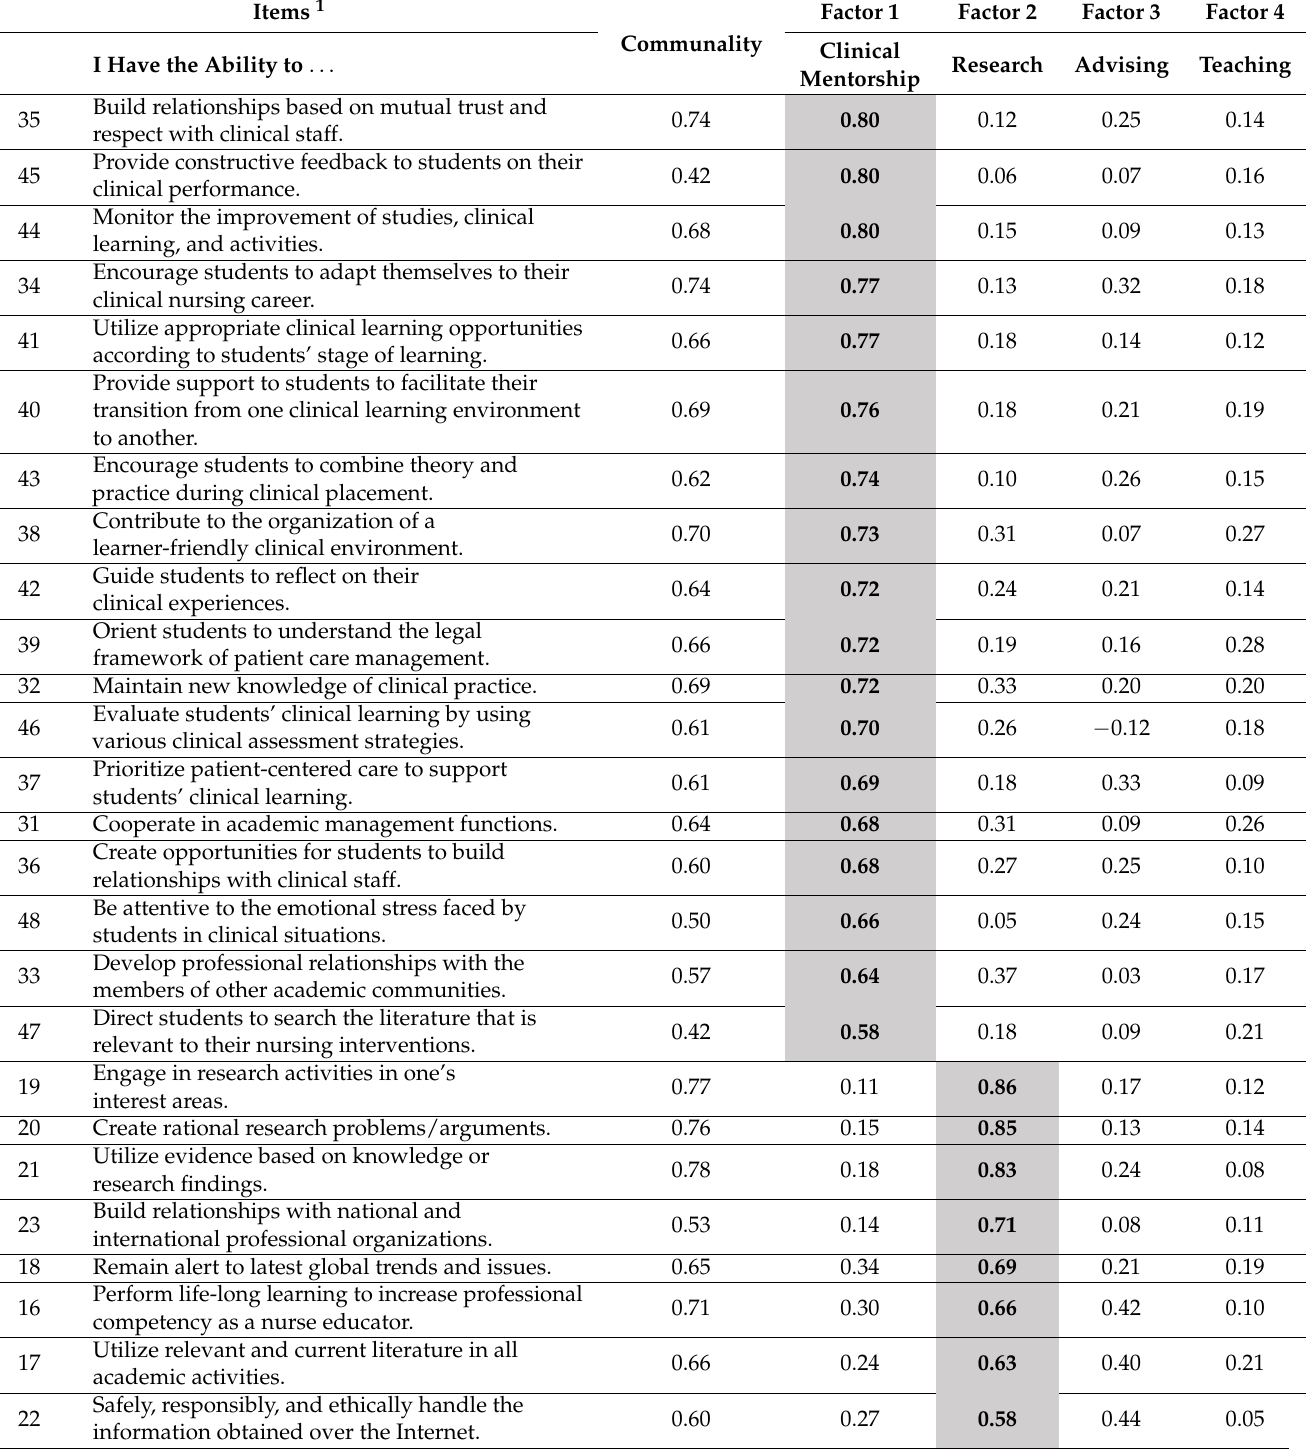
Table 3. Factor loadings of the second exploratory factor analysis ( n = 126). Items 1